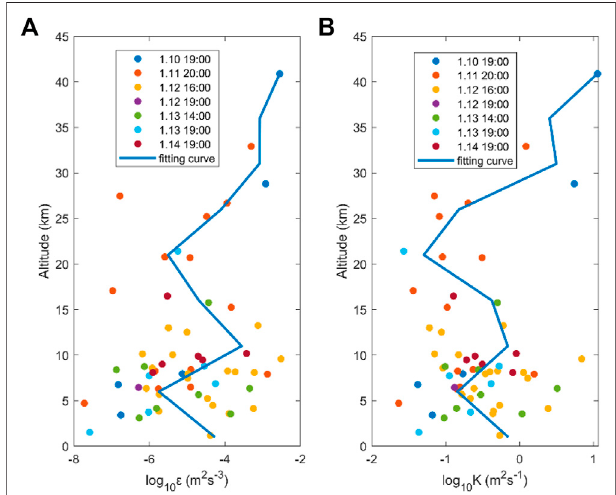
FIGURE 8 | The vertical distribution diagram of turbulent kinetic energy dissipation rate and turbulent diffusion coef fi cient from January 10 to 14, in which the solid blue line is the fi tting distribution pro fi le by cubic spline interpolation, (A,B) show the turbulent kinetic energy dissipation rate and turbulent diffusion coef fi cient